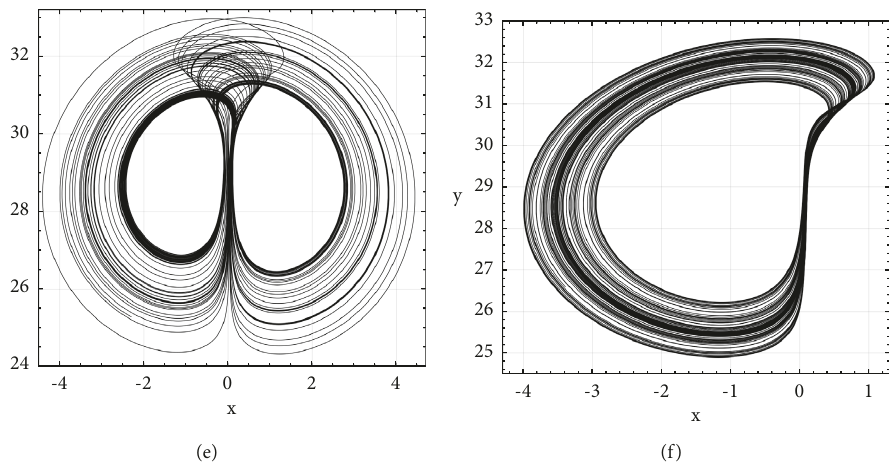
� 0.02, (b) T � 0.12, (c) T � 0.05, (d) T � 0.03, 3 : (a) T 3 3 3 3